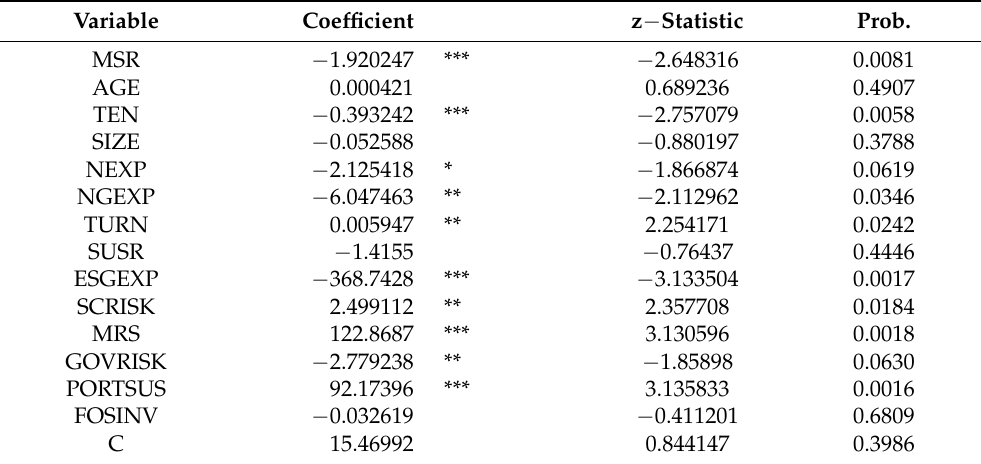
Table 7. Impact of fund characteristics on the price transmission from oil prices to mutual fund